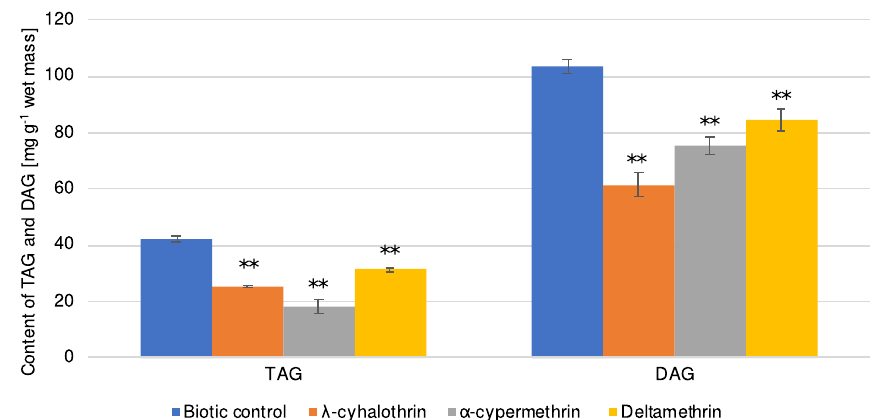
Figure 2. Content of tri- and diacylglycerols in the B. bassiana cells after 48 h of cultivation with λ-cyhalothrin, α-cypermethrin and deltamethrin at a concentration of 100 mg L −1 . All samples were prepared in triplicate, and the experiments were repeated twice. Results were tested by one-way ANOVA; significance: ** P < 0.01, * P < 0.05.